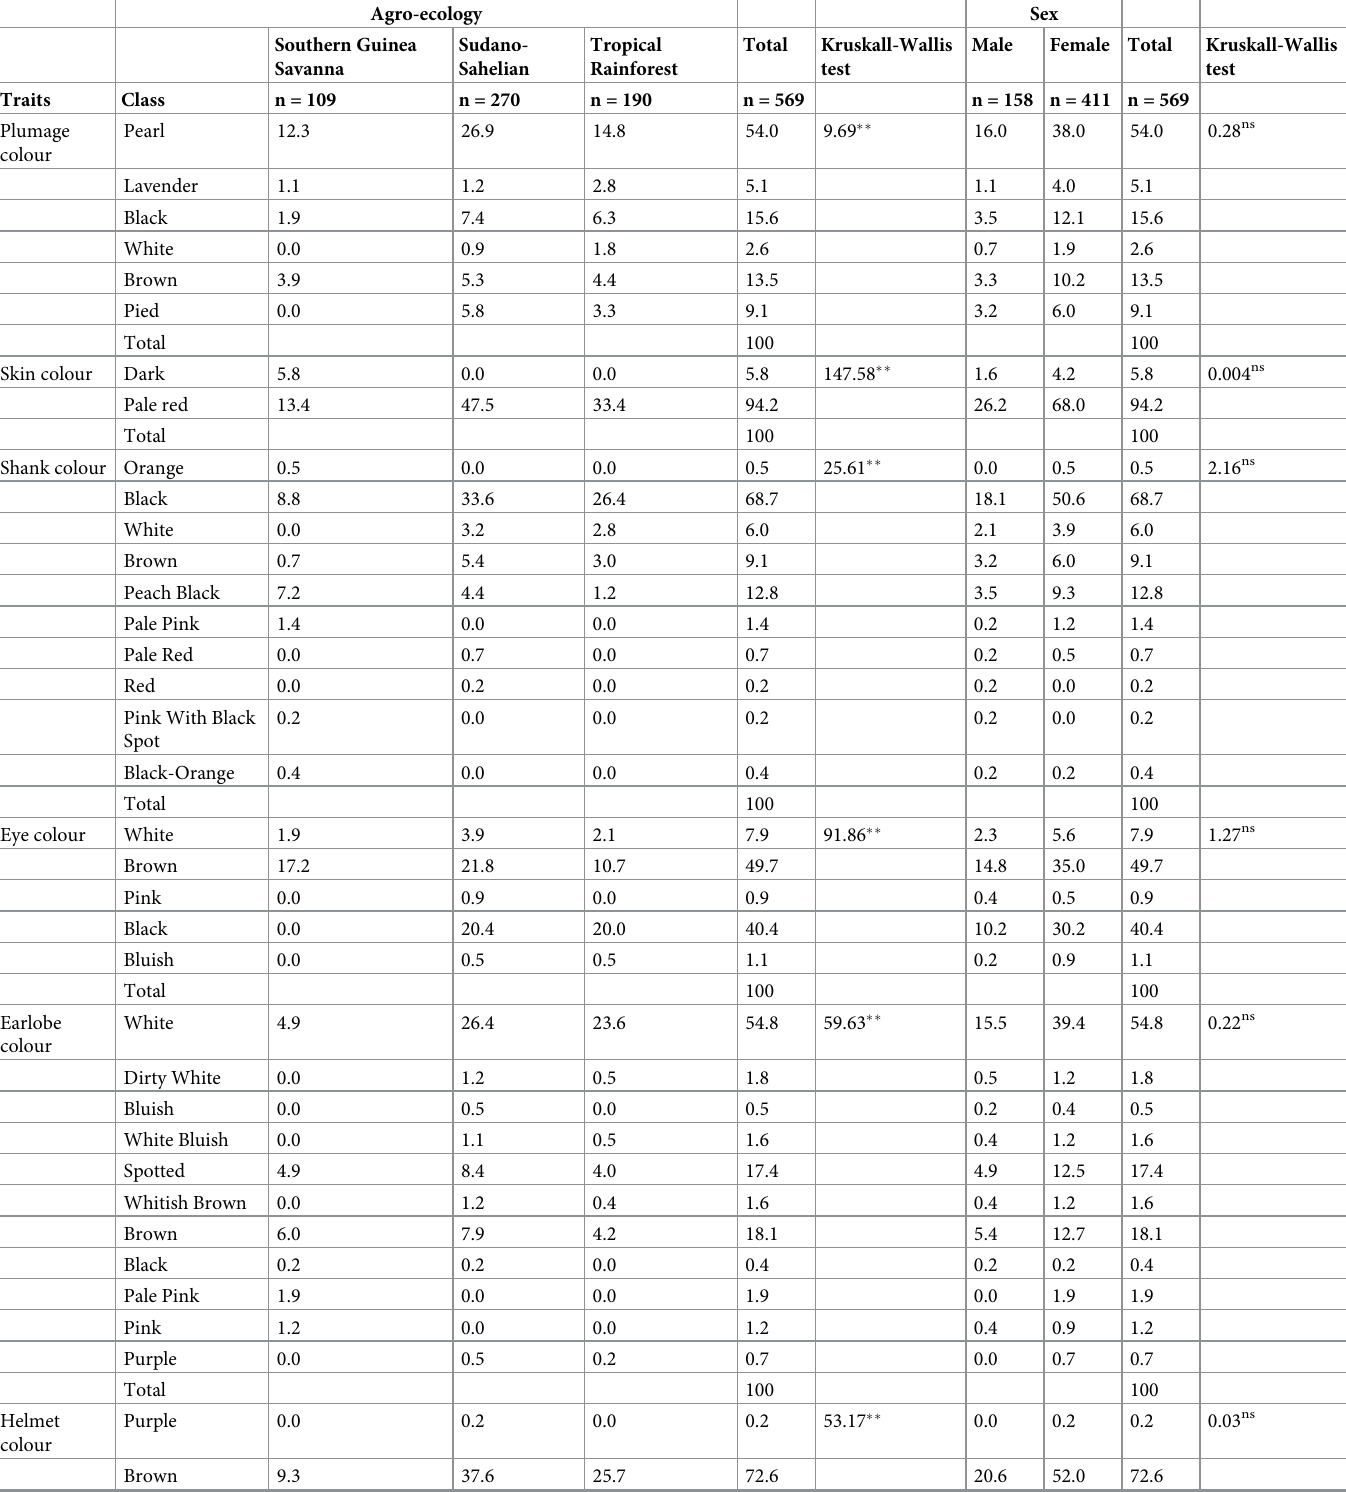
Table 1. Frequency (%) of colour traits of indigenous helmeted Guinea fowl based on agro-ecology and sex.